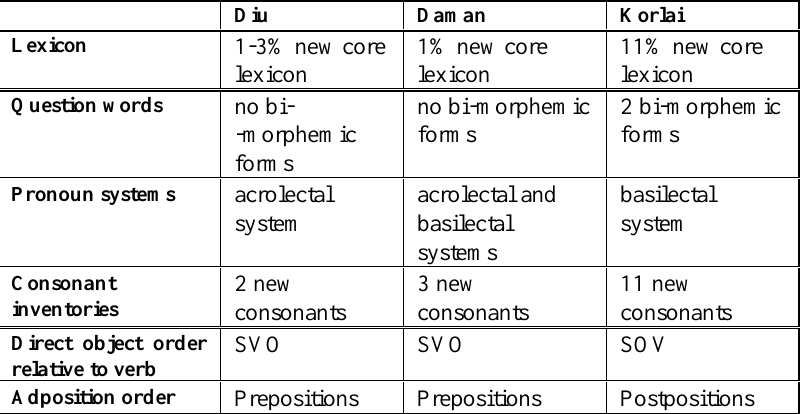
Table XVI. Summary of the differences in Diu, Daman, and Korlai Daman